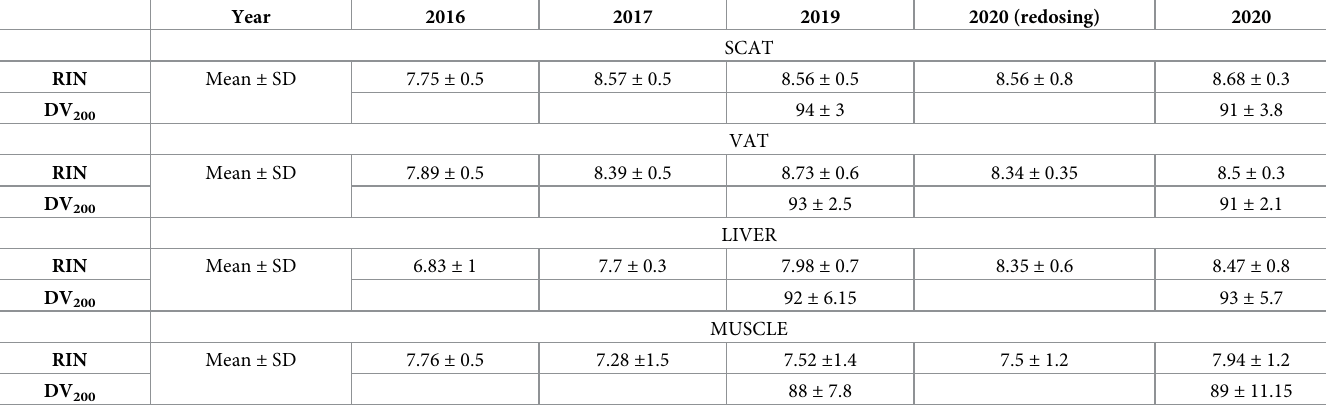
Table 7. Quality metrics of RNA isolated from frozen tissues after different time of storage in the biobank. Mean RIN ± SD were shown for RNA samples extracted from frozen tissues (SCAT, VAT, liver, and muscle) in 2016, 2017 and for RNA samples obtained from the same tissues and patient in 2019 and 2020. RNA samples extracted in 2016 and 2017 were also re–evaluated in 2020 (“redosing”). Mean DV200 ± SD were shown for RNA samples extracted in 2019 and